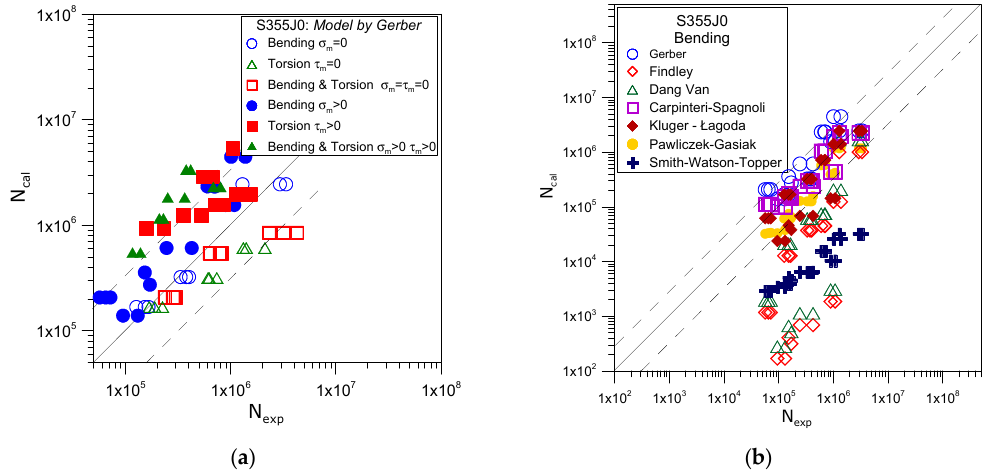
Figure 2. Comparison of calculated and experimental fatigue life for S355J0 steel; ( a ) for the Gerber model and various types of load; ( b ) for bending and various calculation models.